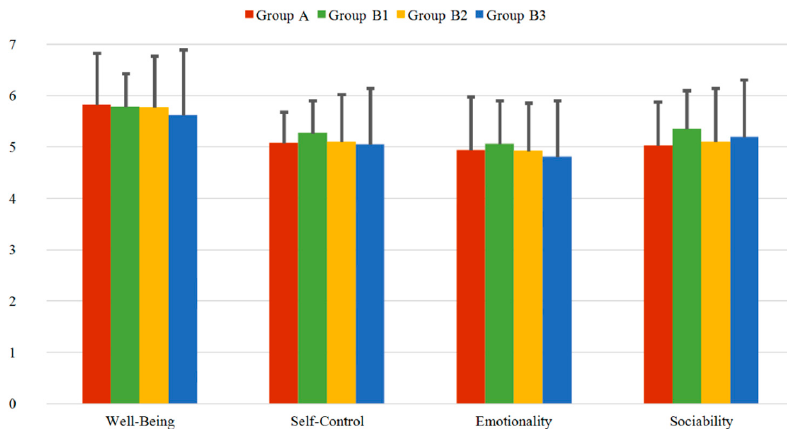
Figure 6. Mean values of the four dimensions of the TEIQue-SF questionnaire for the different groups. The error bars represent the corresponding standard deviations.